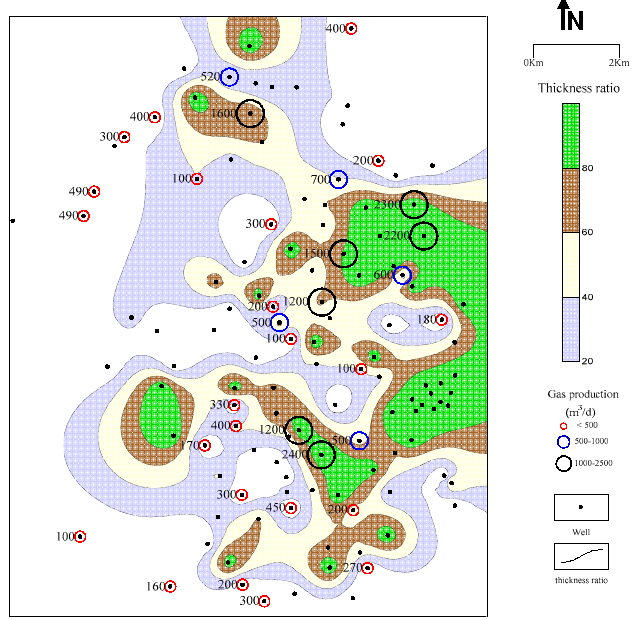
Figure 9. Overlay isopach map of the well-preserved coal thickness ratio and gas production of the No. 11 coal seam.